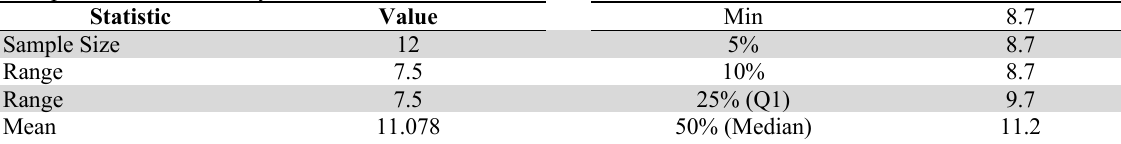
Fig. 2. The result of monthly rice production at Bandung Regency 2008-2019 Descriptive statistics of rice yield